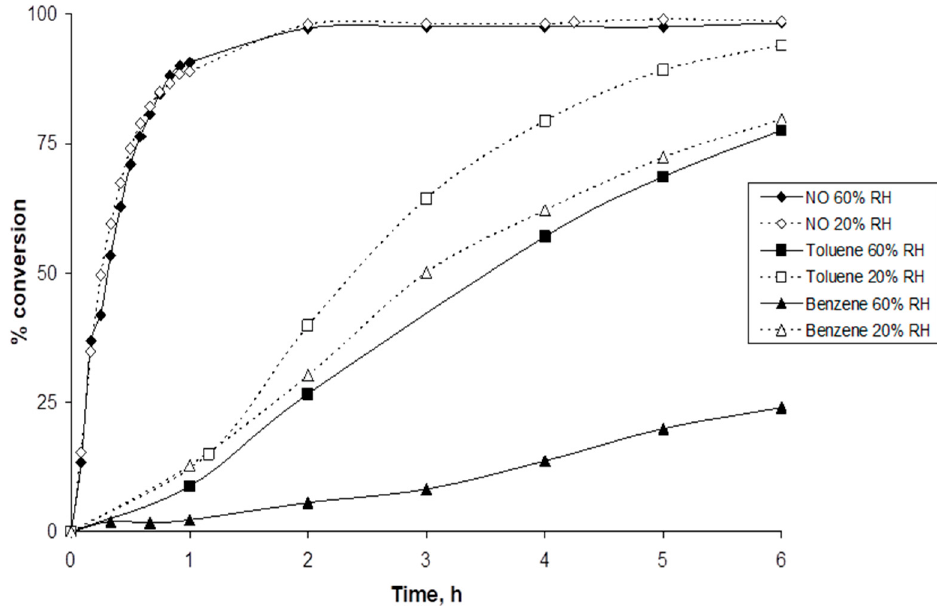
Figure 3. Influence of humidity on the photocatalytic degradation of NO, benzene, and toluene.